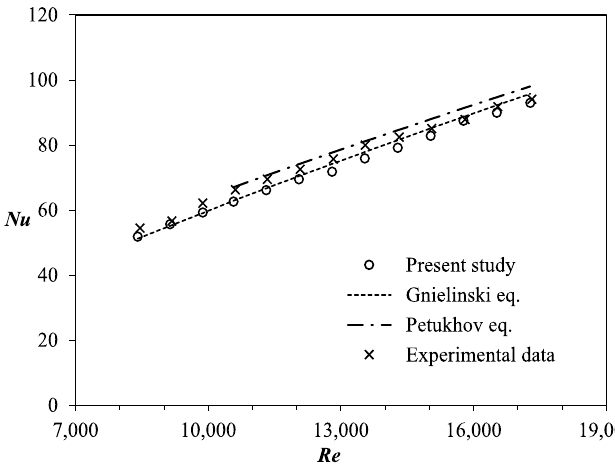
Figure 2. Validation of Nu for plain tube.